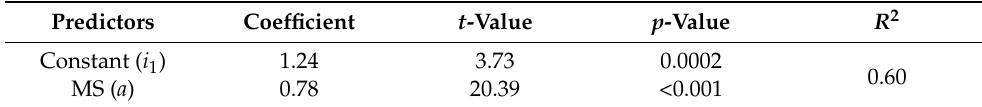
Figure 4 . Hypothesis 1 regression results . Figure 4. Hypothesis 1 regression results. Table 2. Linear regression result using Equation (1); outcome: SS. Table 2. Linear regression result using Equation (1); outcome: SS.